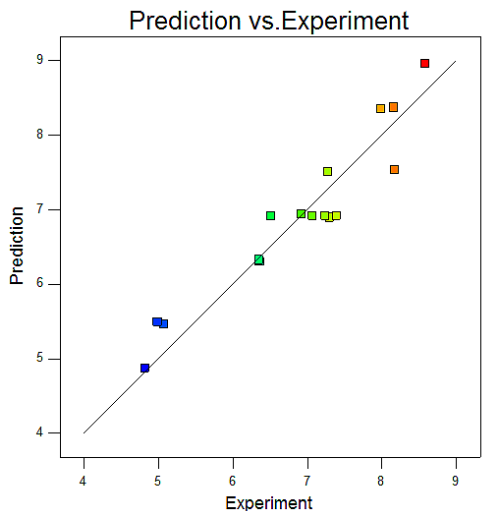
Figure 5. Comparison between predicted penetration of model and actual penetration value.